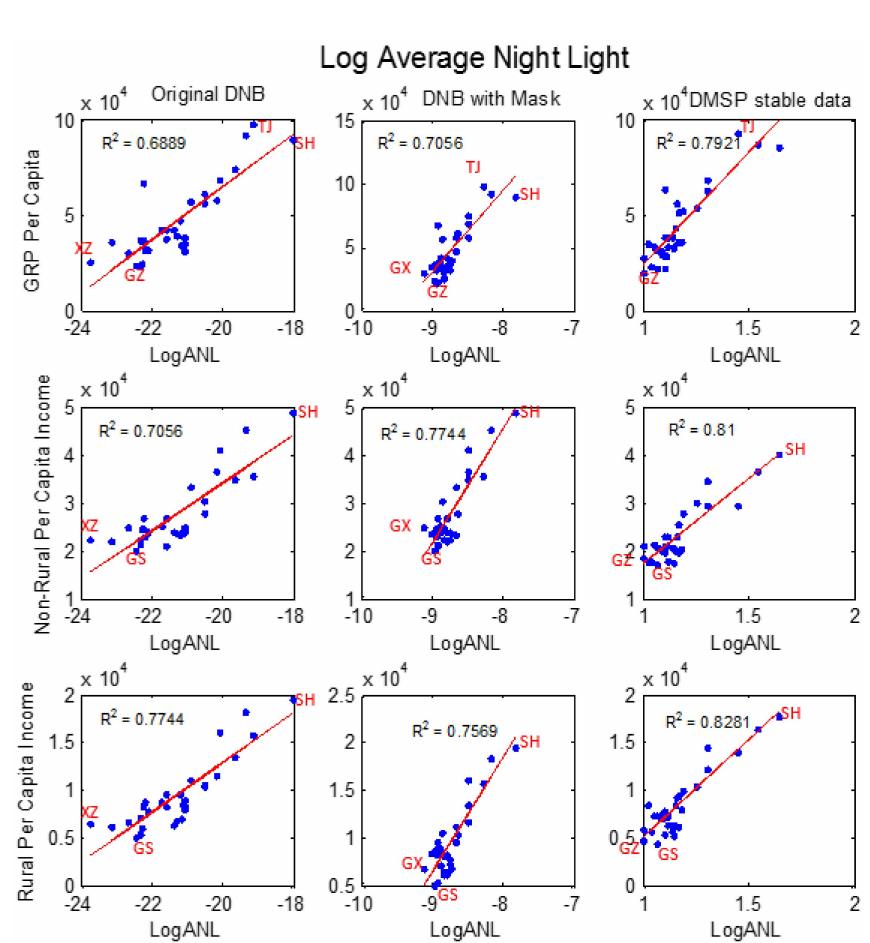
Figure 6. Scatter plots of log ANL vs. socio-economic parameters (1st row: GRPPC; 2nd row: CTPCI; 3rd row: RPCI) together with the fitting curve (in red) from regression. log ANL data used in the 1st, 2nd and 3rd column are derived from original DNB composite data in 2013, DNB NMM in 2013 and DMSP-OLS stable data in 2012, respectively. Red labels in the panel denote: GS, Gansu; GZ, Guizhou; GX, Guangxi; SH, Shanghai; TJ, Tianjin; XZ,